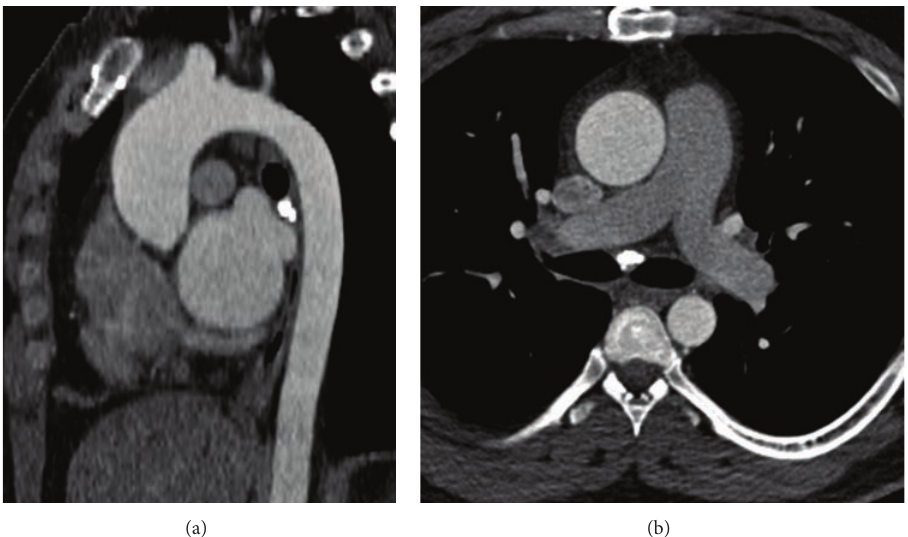
Figure 4: Aortic dilation—(a) sagittal oblique reconstructed CT in a 41-year-old male shows dilated ascending aorta (4.6cm) not having reached the size required for a diagnosis of aneurysm. (b) Axial CT image shows the dilated ascending aorta but normal descending thoracic